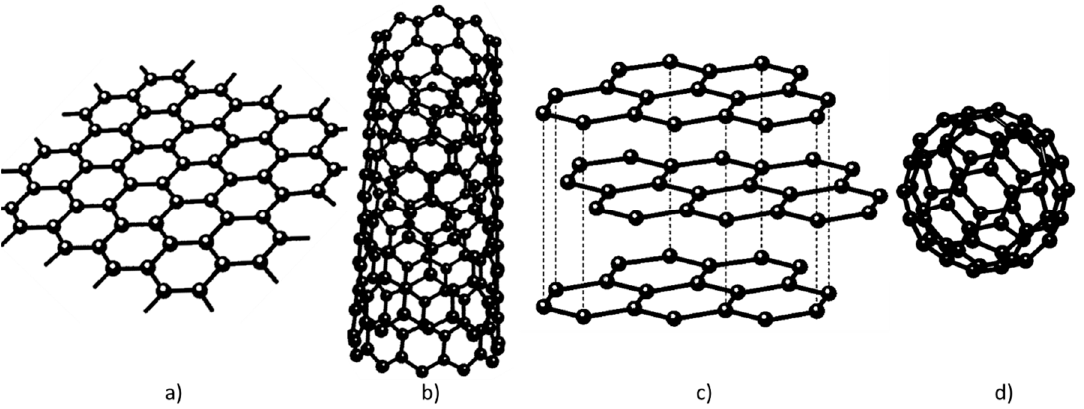
Figure 3. Allotropes of carbon: ( a ) 2-D graphene; ( b ) 1-D carbon nanotube; ( c ) 3-D graphite; ( d ) 0-D fullerene; adapted after [16].